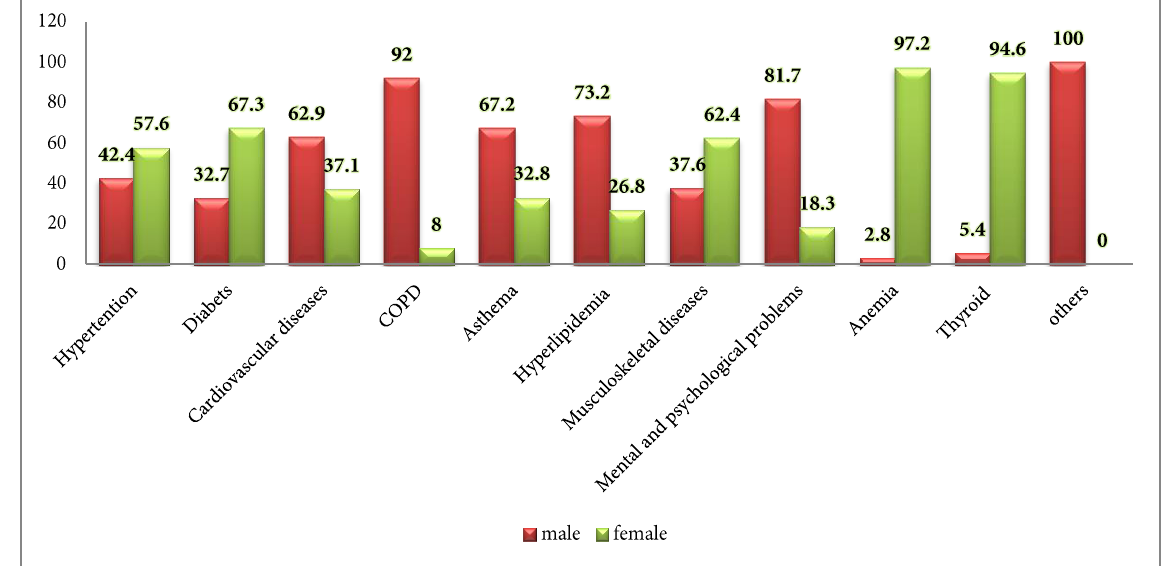
Figure 2. Prevalence of chronic disease by gender in patients referred to Iranian clinics in Iraq from April to May